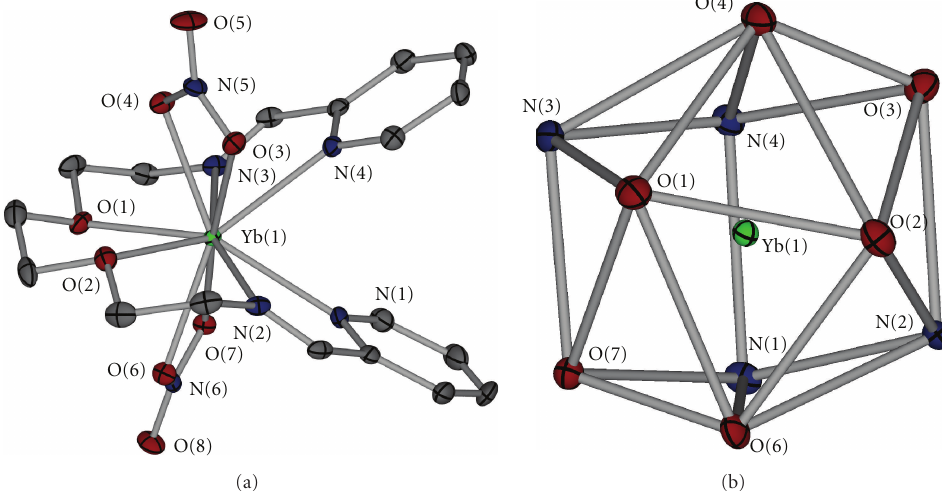
Figure 1: (a) A thermal ellipsoid plot of the cation in 4 , including a partial labelling scheme. The hydrogen atoms have been omitted for clarity. (b) The coordination polyhedron about Yb(1) in 4